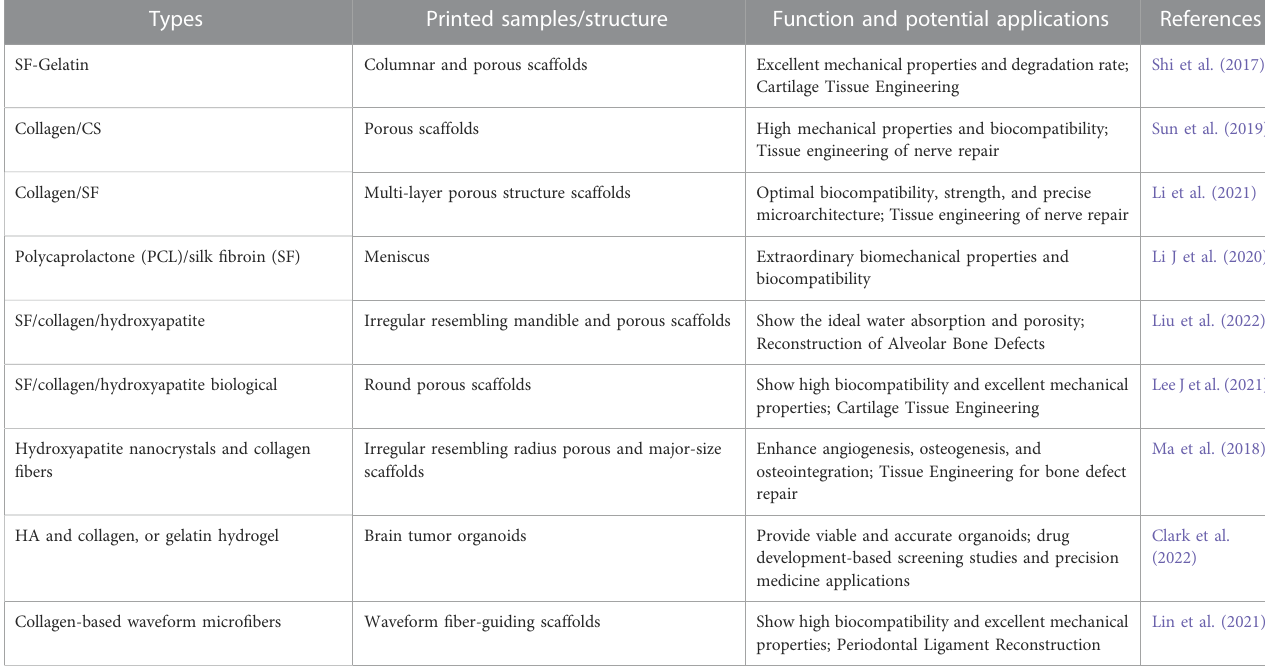
TABLE 3 The 3D printing of biomass protein fi ber materials in medical